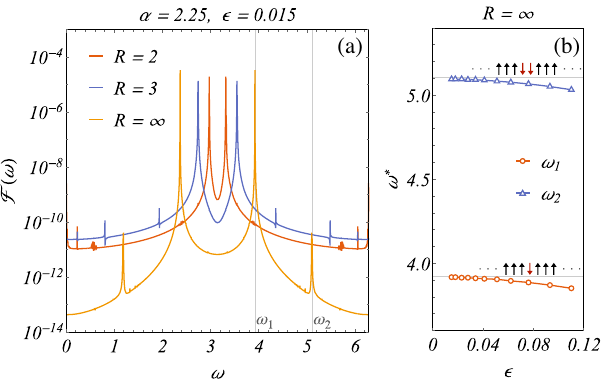
FIG. 16. (a) Discrete Fourier transform of the order-parameter time series for ϵ ¼ 0 . 015 , α ¼ 2 . 25 , and different interaction ranges R . Data have been obtained via ED with L ¼ 28 and time series up to 2000 kicks. (b) Positions of the first two peaks (at ω > π ) as a function of ϵ in the long-range case R ¼ ∞ , which are expected to match the “ classical ” single or double spin-flip excitation value, for ϵ ¼ 0 (see main text